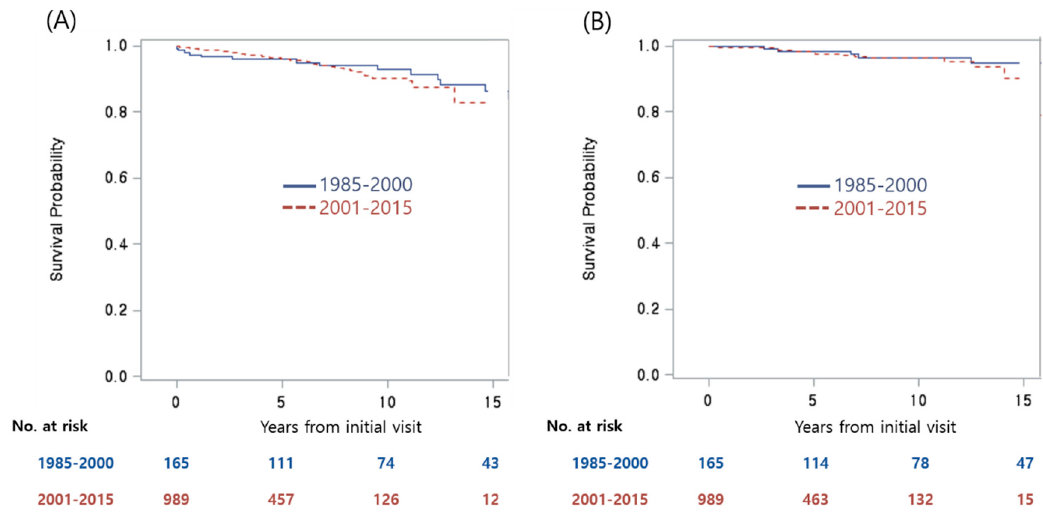
Figure 2. CKD–free ( A ) and ESRD–free ( B ) survival rates among patients presenting between 1985 and 2000 and those presenting between 2001 and 2015. CKD: chronic kidney disease stage 3–5; ESRD: end–stage renal